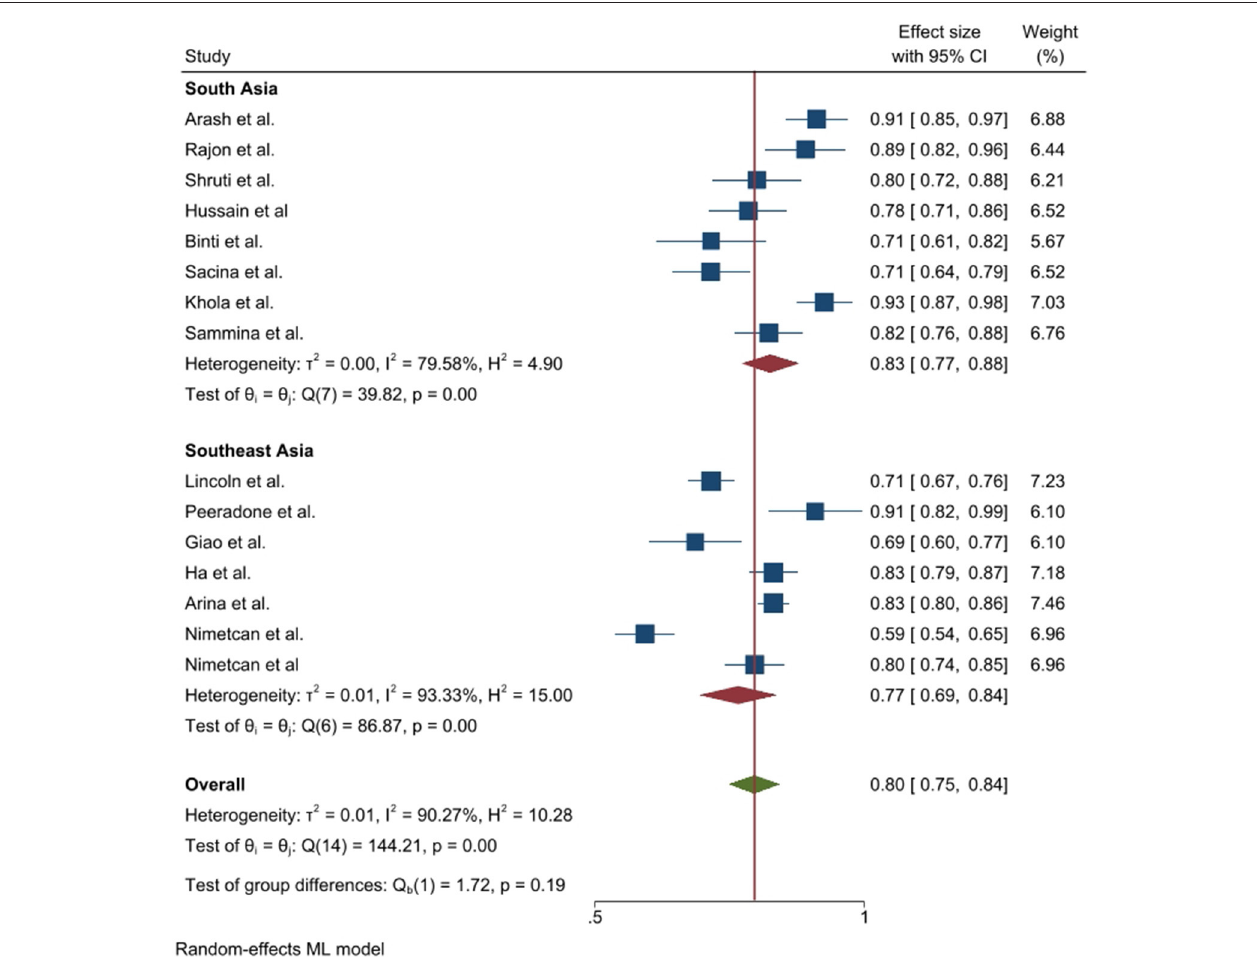
FIGURE 5 | Prevalence of positive attitude toward COVID-19 epidemic in Southeast and South Asia, stratified by